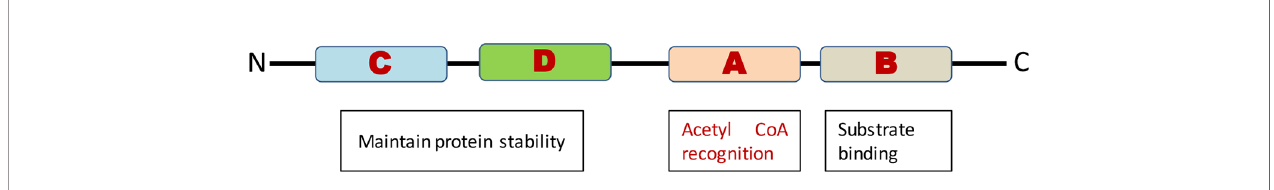
FIGURE 2 | Conserved motifs of GNATs and their functions.